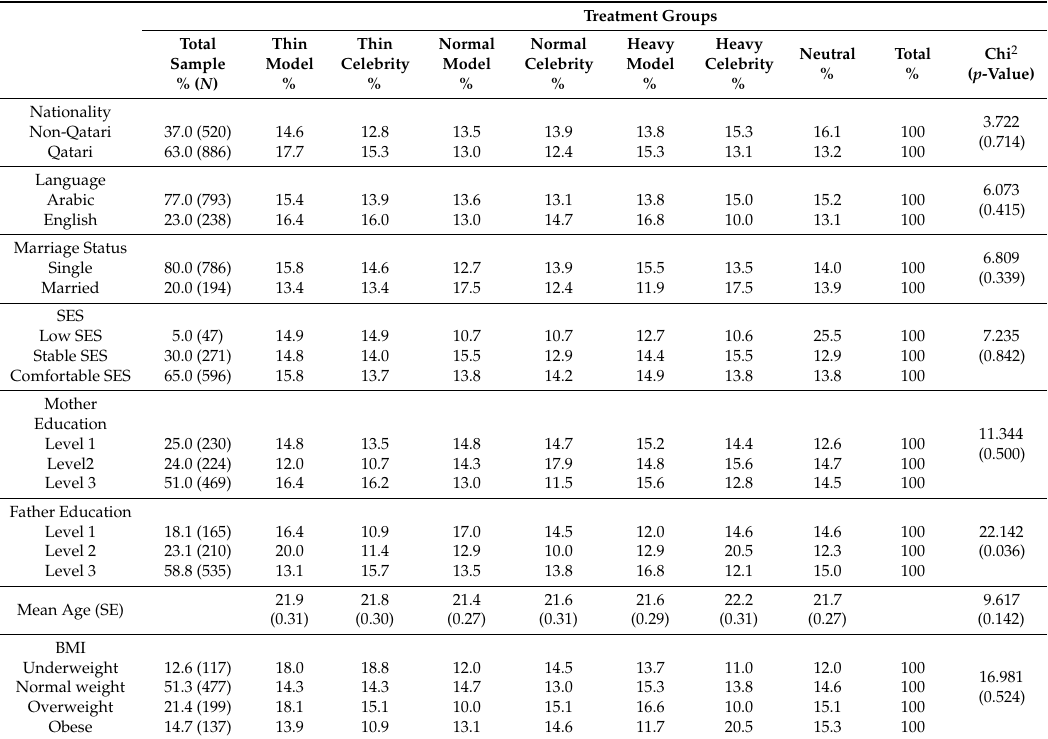
Table 1. Percentages for Manipulation Check. Treatment